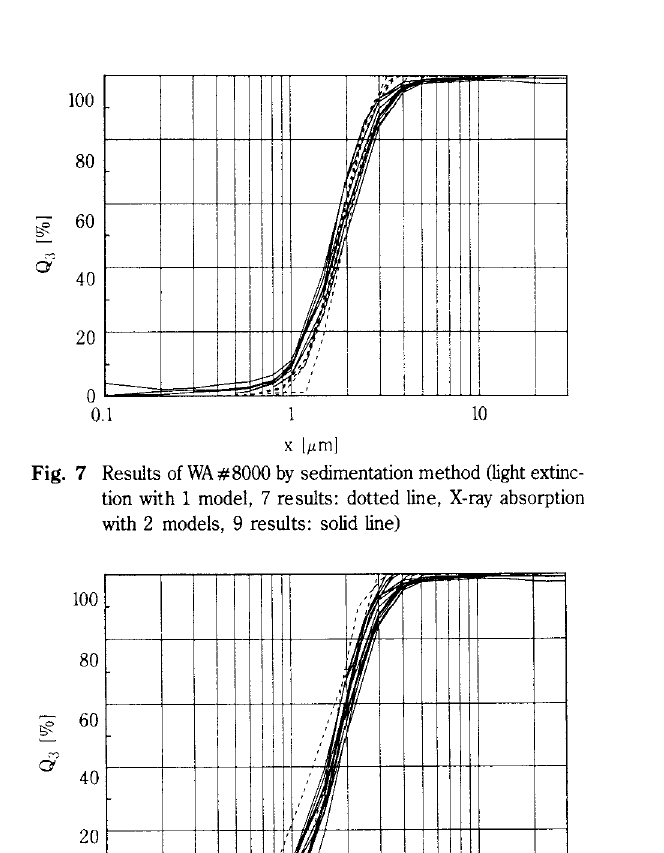
Fig. 8 An overlap of weight method (dotted line) onto Fig. 7